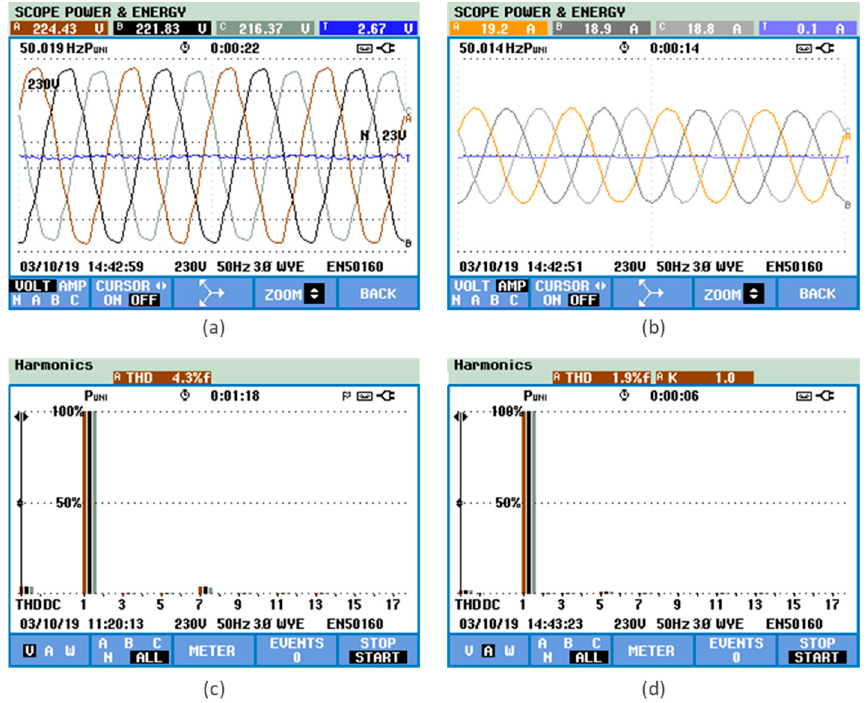
Figure 8. Experimental validation showing: ( a ) The voltages on the AC-side ( v ga , v gb , v gc ); ( b ) The currents on the AC-side ( i UTa , i UTb , i UTc ); ( c ) The harmonic spectrum and the THD value of the voltages on the AC-side; ( d ) The harmonic spectrum and the THD value of the currents on the AC-side.